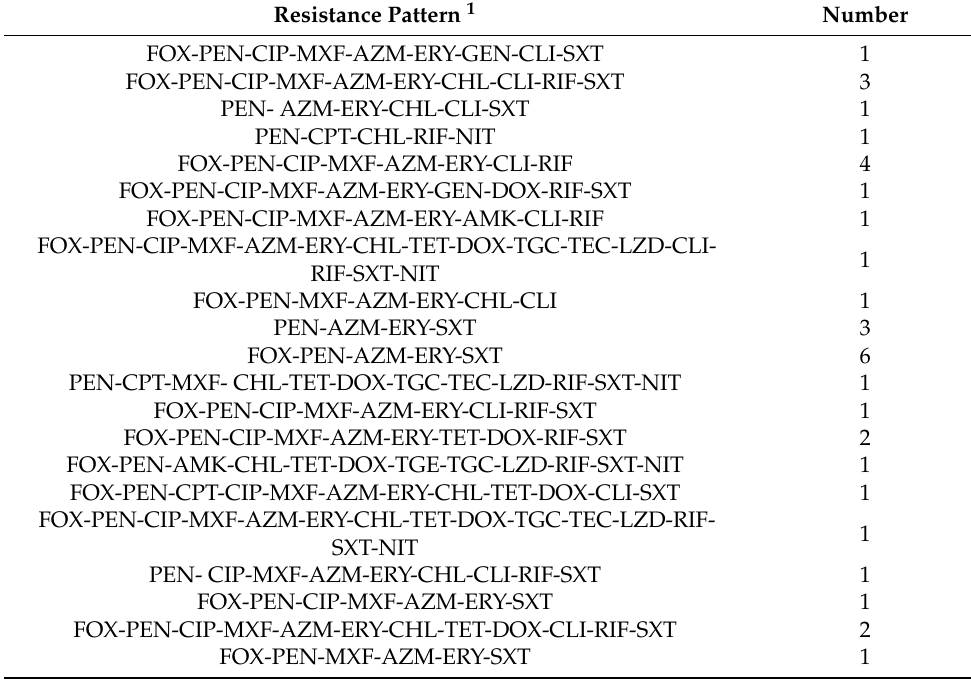
Table 4. Resistance pattern observed in MDR CoNS ( n =